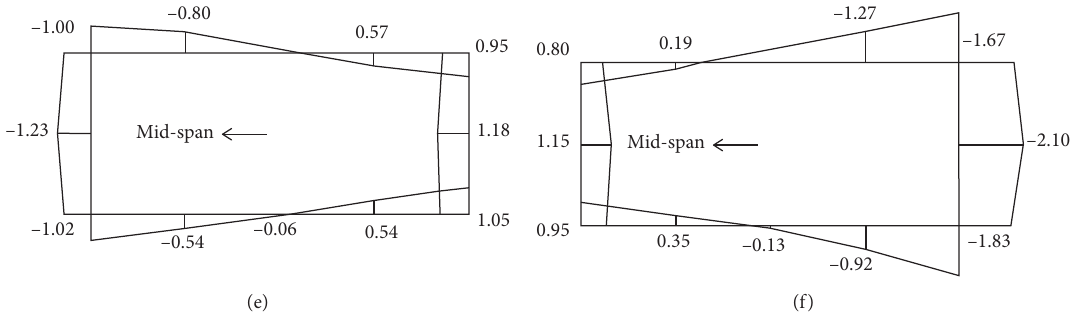
Figure 7: Stress distribution diagram of section no. 5 tower column under live load (unit: MPa). (a) Working condition 3, T3 section’s positive moment loading stress diagram. (b) Working condition 4, T3 section’s negative moment loading stress diagram. (c) Working condition 5, T4-1 section’s positive moment loading stress diagram. (d) Working condition 6, T4-1 section’s negative moment loading stress diagram. (e) Working condition 5, T4-2 section’s positive moment loading stress diagram. (f) Working condition 6, T4-2 section’s negative moment loading stress